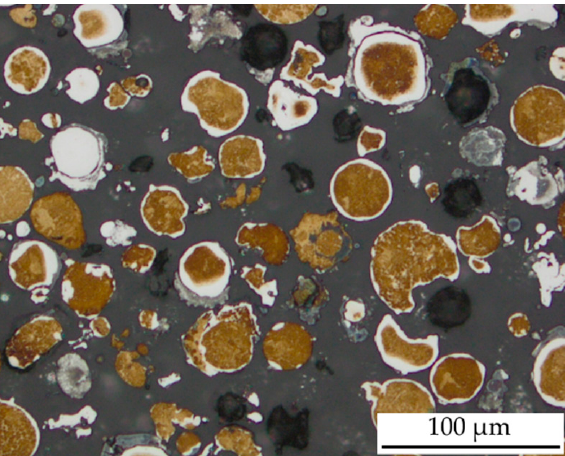
Figure 1. Optical-microscopic image of Beraha-II-etched AISI 316L powder feedstock after gas nitrocarburization.